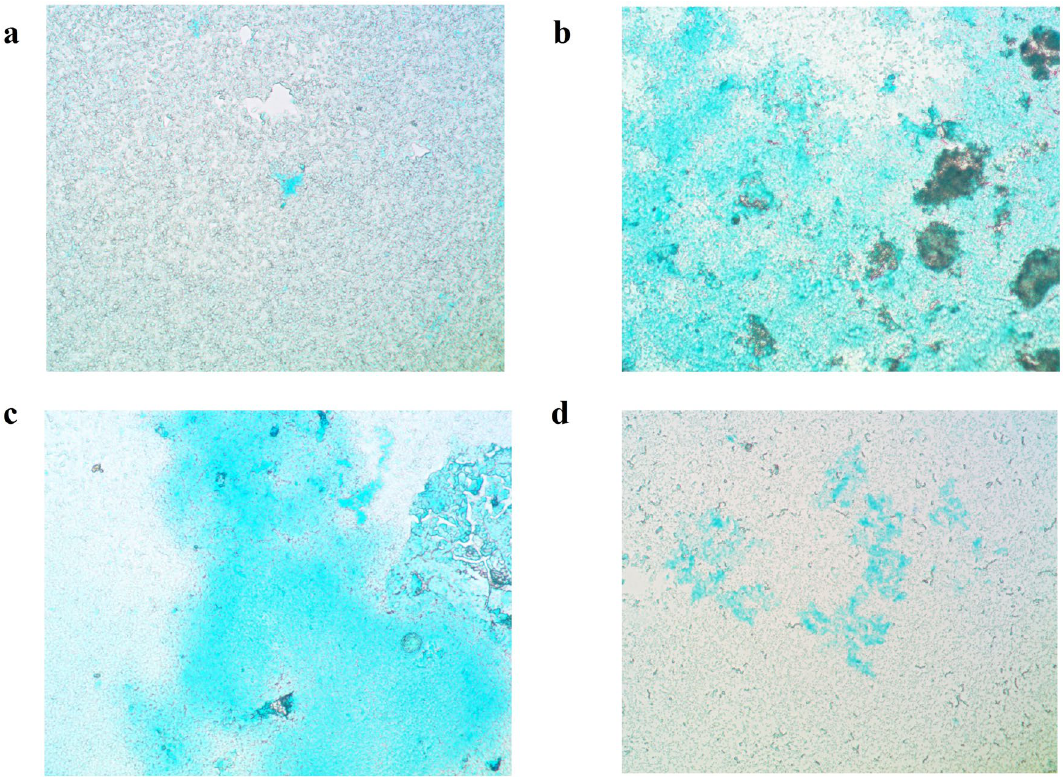
Figure 5. Light microscopy images of stained 21-day biofilm polysaccharides of E. faecalis after 7 days of contact with solutions. ( a ), Control, no solution; ( b ), Ca(OH) 2 ; ( c ), Ca 2+ ; ( d ), OH -